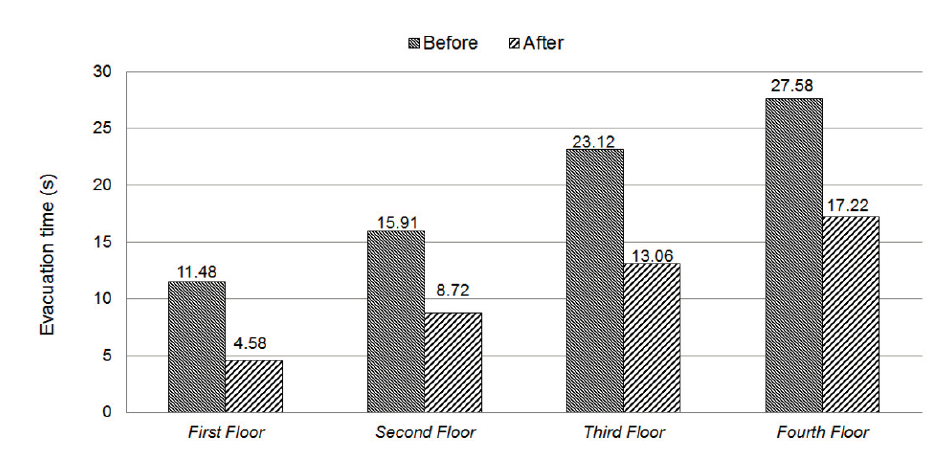
Figure 15. Comparison of evacuation time.